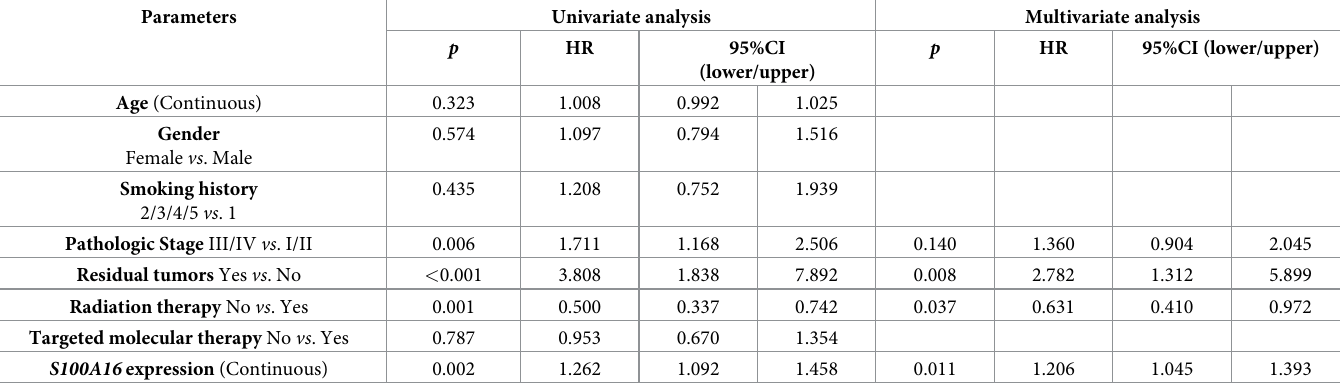
Table 3. Univariate and multivariate analysis of RFS in LUAD patients. Parameters